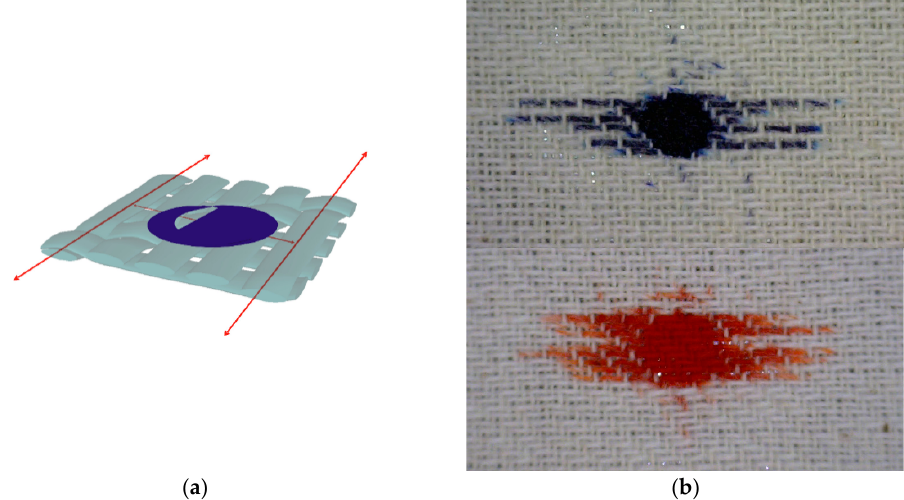
Figure 11. Diagonal “channels” on the surface of the fabric in twill 1/3 weave: ( a ) twill weave 3D simulation. Distribution of blue and red dye drops through the diagonals of the fabric in the twill weave: ( b ) start position, ( c ) end position.